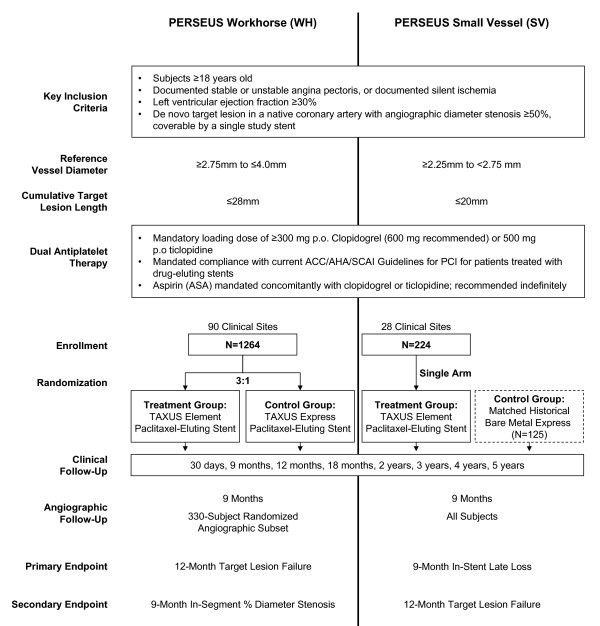
PERSEUS WH and PERSEUS SV Study Schematic.